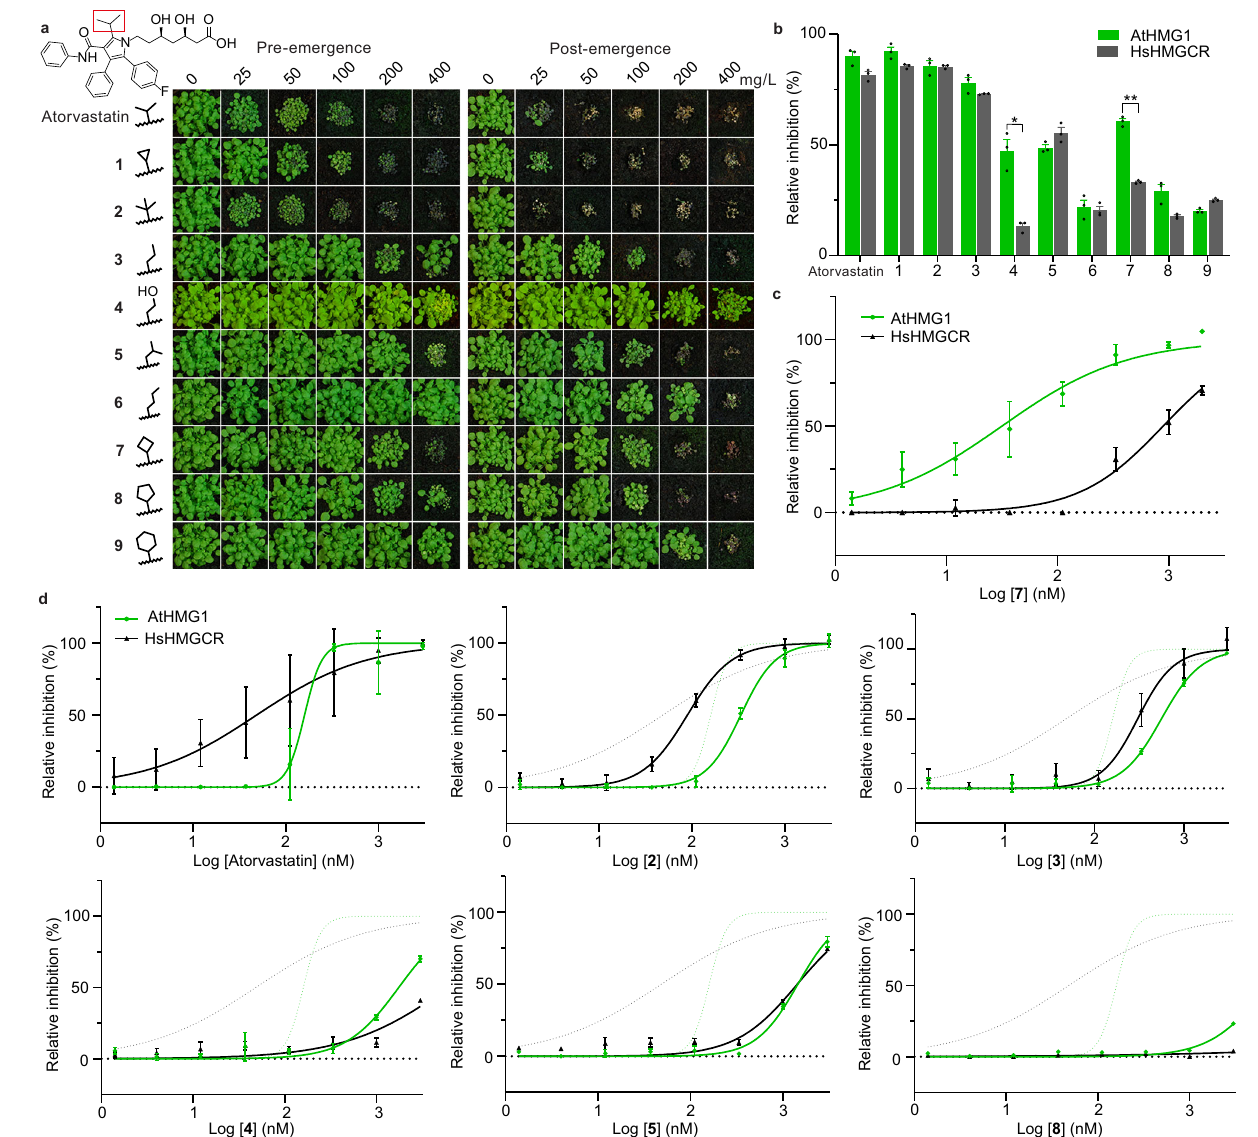
Fig. 4 | Modifying the isopropyl group of atorvastatin affects species selectiv- ity. a Herbicidal activity of atorvastatin and its analogues ( 1 – 9 ) against A. thaliana with pre- and post-emergence treatments. The isopropyl moiety of atorvastatin is boxedinred.Modi fi cationstotheisopropylregionareshown. b Compounds 4 and 7 were selective in vitro for AtHMG1 (green bar) over HsHMGCR (grey bar) at 500nM. n =3 independent reactions with the mean ± s.d. Signi fi cance from two- tailedpaired t test,values:compound 4 t =5.536 df =2 P =0.03(*)95%CI[ − 60.92to − 7.635], compound 7 t =16.93 df =2 P =0.003 (**) 95% CI [ − 34.37 to − 20.44]. c In